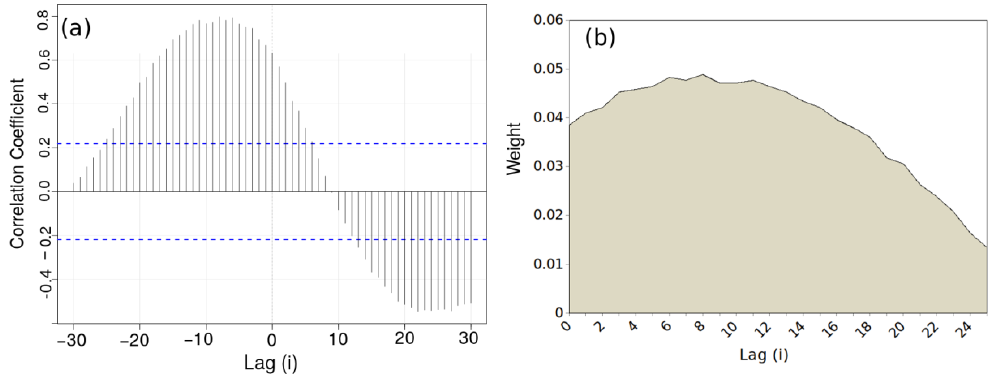
Figure 7. ( a ) Cross-correlation diagram between IW t − i and N t for different lags of IW (e.g., i = 0, 1, 2, 3…, n months). Negative numbers mean that IW precedes N t . ( b ) Contribution (w i ) of each lag i to the prediction of the total of number of earthquakes in a particular month t (N t ), to be applied to the